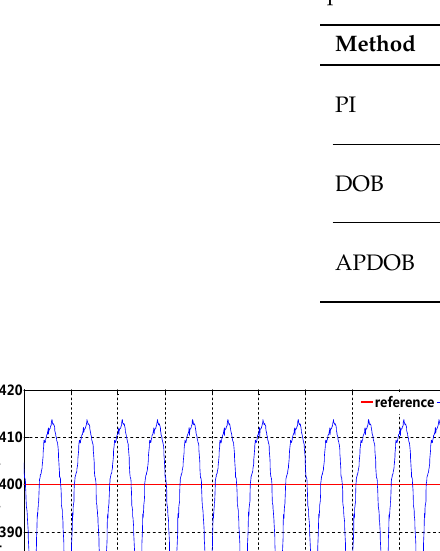
Table 4. Speed fluctuation ratio and corresponding error.